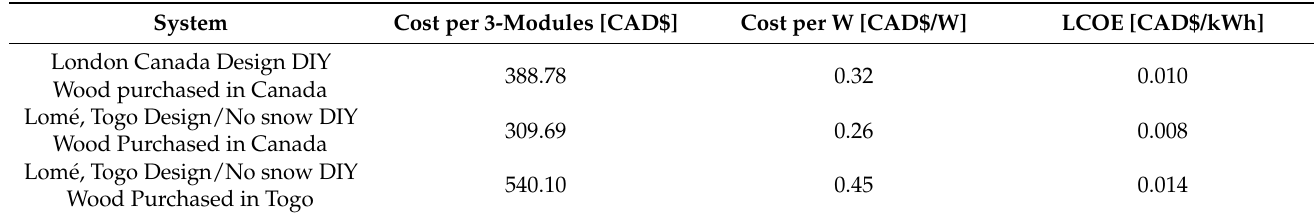
Table 7. Cost per 3 modules, Cost per W, and LCOE for each system in $CAD.